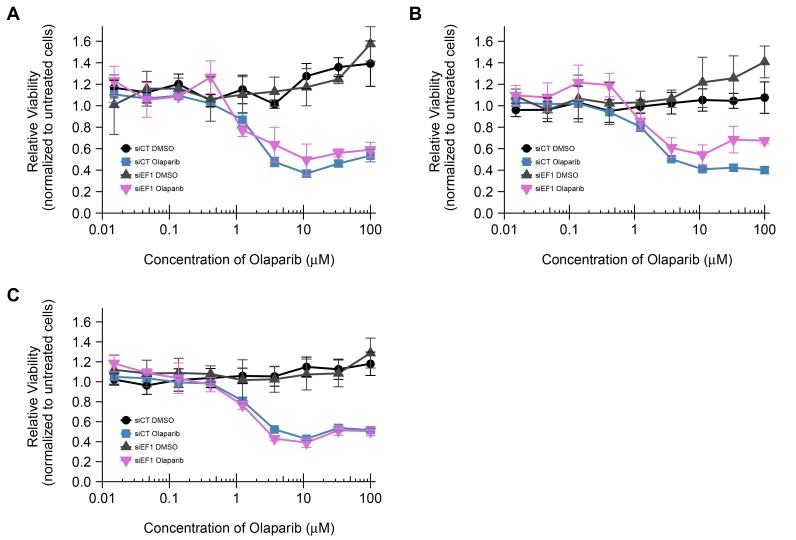
Cell viability assays for each biological repeat.This is the same experiment as in Figure 3. The line graph of each biological repeat is plotted individually. Means reported and error bars represent SD from three technical replicates for each measurement. Additional details for this experiment can be found at https://osf.io/2w22x/.